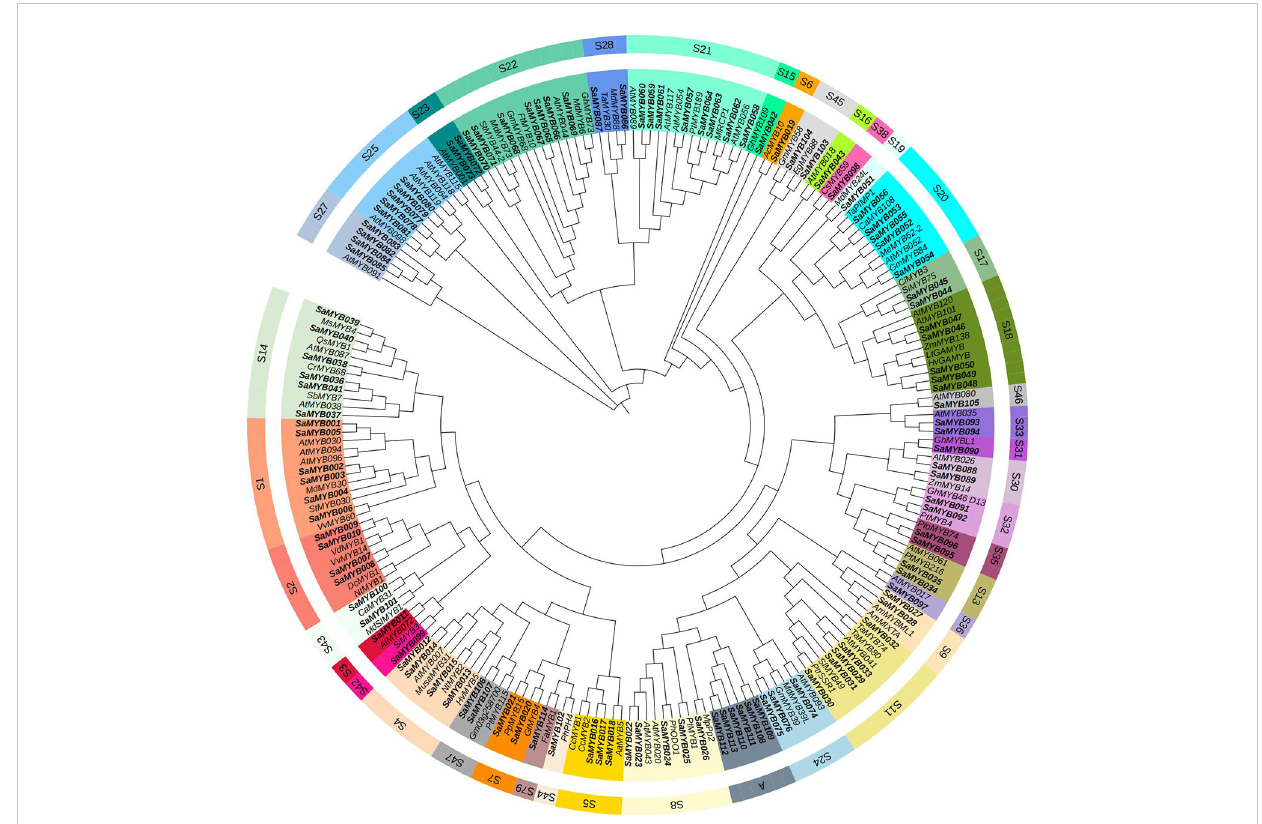
FIGURE 1 Result of phylogenetic analysis of R2R3-MYB proteins in S. album . Same color font of genes represent that they were in common subfamilies.